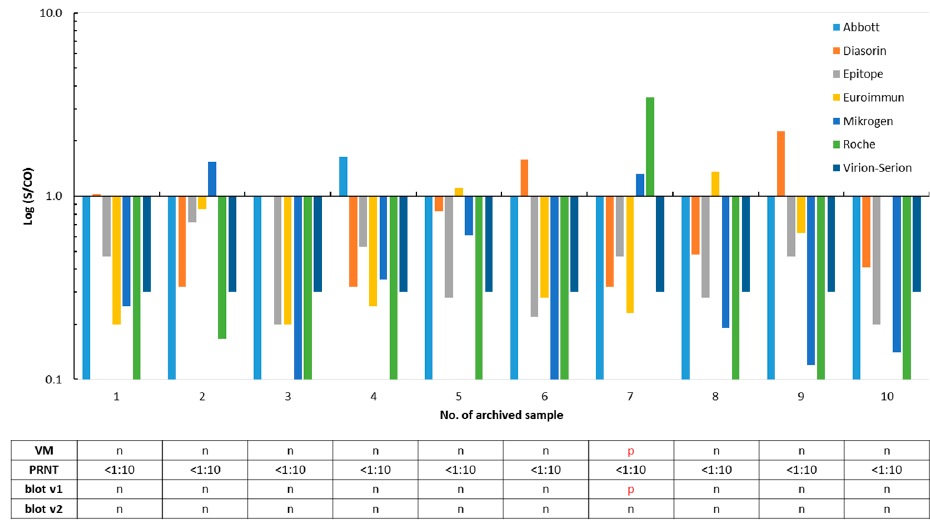
Figure 2. False positivity of SARS-CoV-2 IgG/total antibody tests in ten out of 100 archived sera collected in the summer 2018 and winter 2018/2019. A signal (S)/cut-off (CO) value ≥ 1 is considered as positive for SARS-CoV-2 IgG/total antibodies. Results of the ViraChip ® IgG test (Viramed, VM), of the plaque reduction neutralization assay (PRNT, Figure S1), and of both recom Line assays (blot v1 and v2) are listed in the table. p, positive and n, negative. For better clarity, positive test results are printed in red in the table. Table 1. Sensitivities, specificities, and accuracies of eight severe acute respiratory syndrome coronavirus 2 (SARS-CoV-2) immunoglobulin G (IgG) or total antibody assays calculated from the results of two reference tests. The highest values are shown in green; the lowest values are marked in red. Sensitivity Sensitivity Specificity 3 Accuracy Accuracy